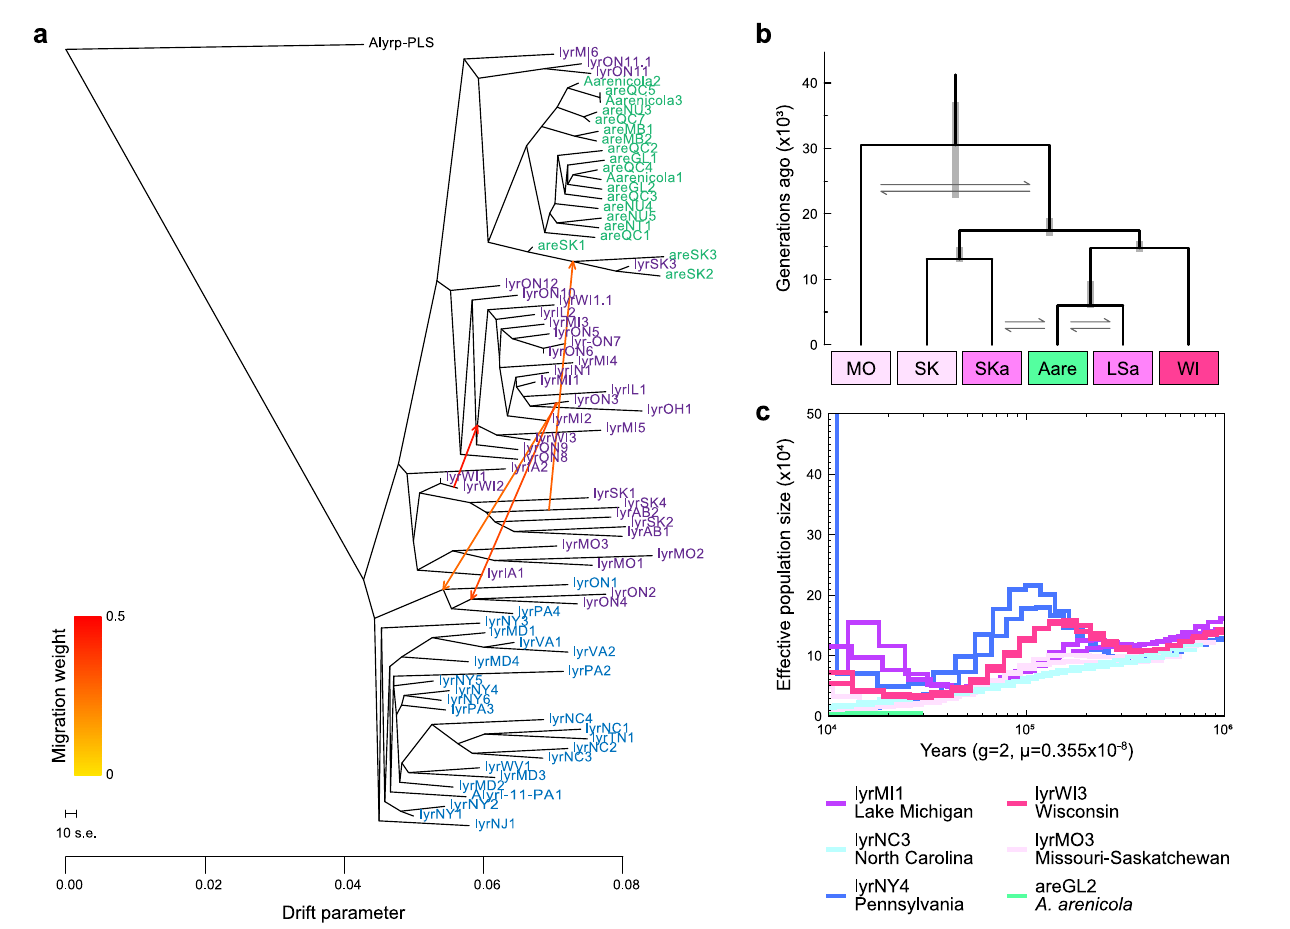
Fig. 2 | Nuclear phylogeny with admixture, split times, and historic effective population sizes. a TreeMix tree based on biallelic synonymous sites of North American Arabidopsislyrata (abbreviatedwithlyr)and A.arenicola (are).Migration eventsandtheirinferreddirectionaredisplayedasorangearrows(scalegivenfrom yellow to red). The scale of 10x the standard error for the drift parameter is indi- cated. Individual names are colored according to their origin for North American samples(eastern clusterof A.lyrata inblue, westernclusterin purple [populations of Lake Erie in colors of predominant ADMIXTURE assignment], A. arenicola in green). b Hierarchical demographic modeling revealed that the best supported model was the one with A. arenicola splitting from northwestern Lake Superior A. lyrata (LSa) some 6000 generations ago, with earlier splits within A. lyrata being